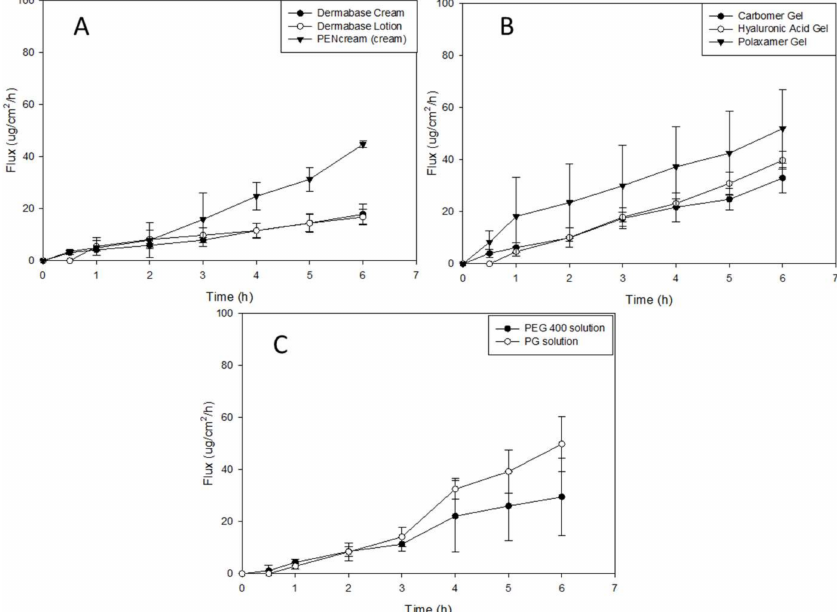
Figure 7. In vitro EpiDerm TM permeation profile of resatorvid: ( A ) 1.25% cream formulations; ( B ) 1.25% hydrogels formulations; and ( C ) 1.25%